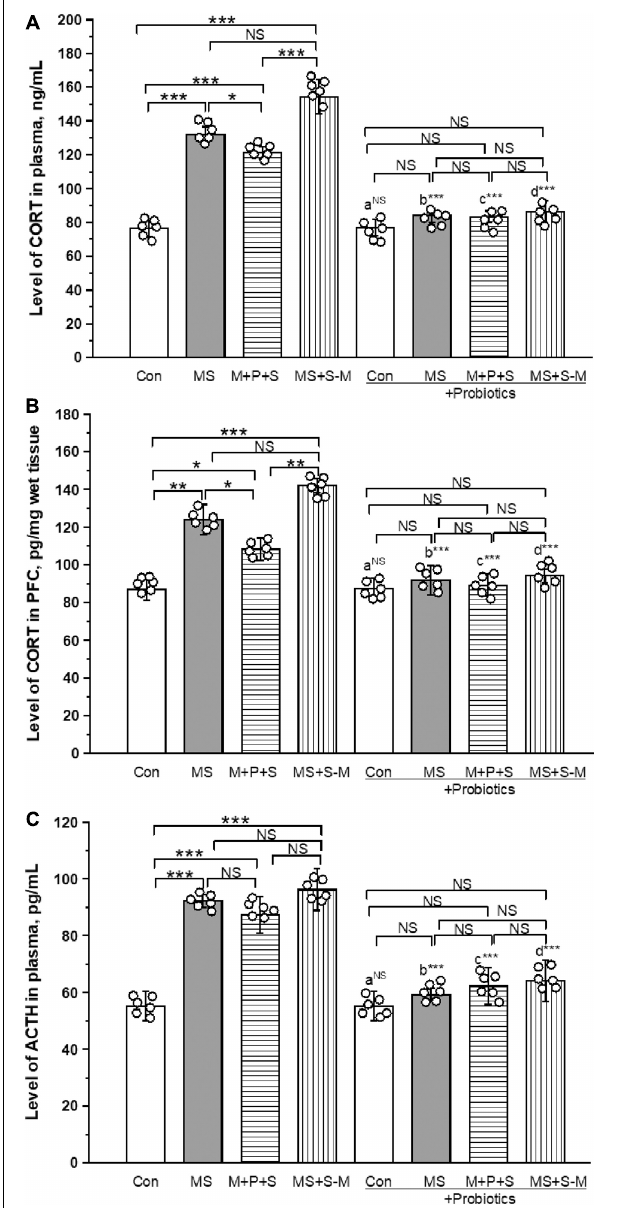
FIGURE 5 | Lactobacillus supplementation significantly prevented early life SSE induced elevation of CORT in plasma (A) , PFC (B) , and plasma ACTH (C) . Values are presented as mean ± SEM. Significant differences between groups are indicated by *** P < 0.001, ** P < 0.01, * P < 0.05; a: con vs. con + Pro; b: MS vs. MS + Pro; c: M + P + S vs. M + P + S + Pro; d: MS+S–M vs. MS+S–M + Pro; NS, not significant.